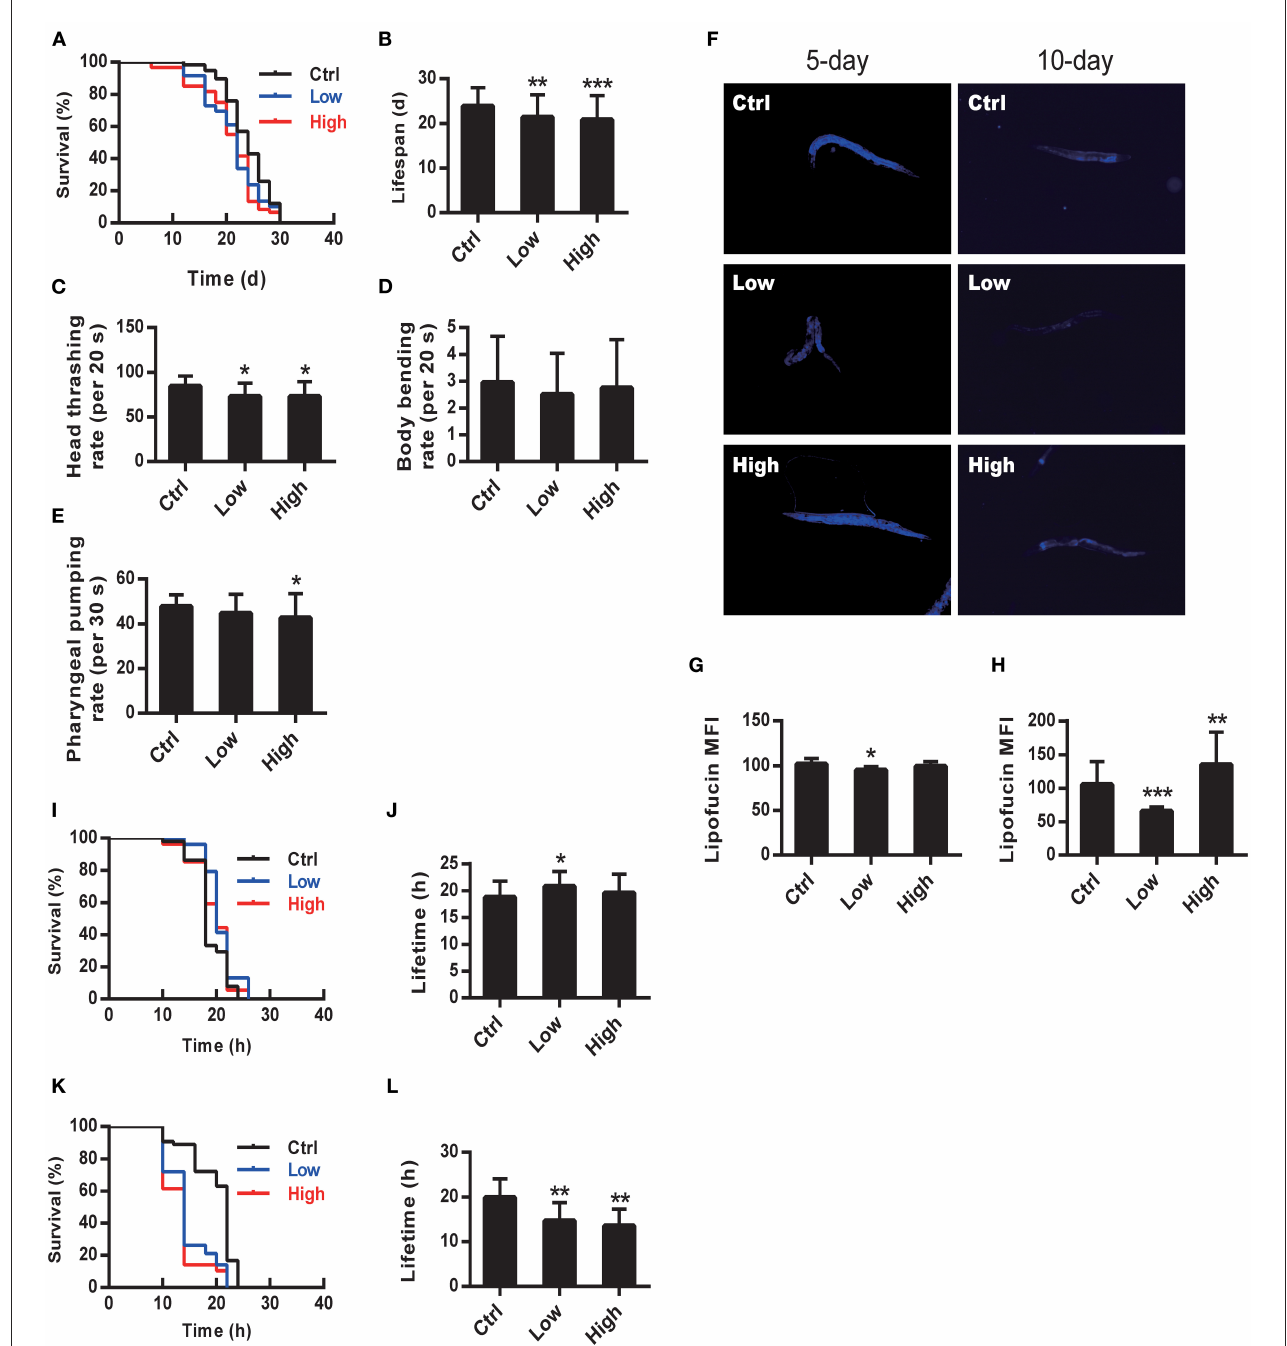
FIGURE1 WS-PM 2.5 exposure reduces lifespan and healthspan in C. elegans . A–H N2 nematodes were exposed to C L sample (with AQI lower than 100 and concentration at 94 µ g/mL) or C H sample (with AQI ranging from 100 to 200 and concentration at 119 µ g/mL) throughout their life circles. Survival curve (A) and average lifespan (B) were recorded and calculated. Head thrashing (C) , body bending (D) and pharyngeal pumping (E) rates were recorded respectively, right after the first 24-h exposure. Accumulation of lipofucin was measured by using fluorescence microscopy after the 5 d (left column of F, G ) or 10 d (right column of F, H ) of exposure. I–L The heat stress tolerance of N2 nematodes was indicated by the lifespan under heat-stress after WS-PM 2.5 exposure. Nematodes were exposed to C H or C L WS-PM 2.5 for 5 d (I, J) or 10 d (K, L) , then cultured under the heat-stress environment (35 ◦ C). Survival curve (I, K) and average lifetime (J, L) were recorded and calculated. In all groups, 60 nematodes were randomly selected for experimental manipulation. All values are given as mean ± SD. Statistical significance was marked with asterisk on the top of bars of each groups vs. corresponding controls, * p < 0.05, ** p < 0.01, *** p < 0.001; F: (C) 4.349, (D) 0.354, (E) 2.227, (G) 12.470, (H) 26.861. “Low” and “High” represents C L and C H group,